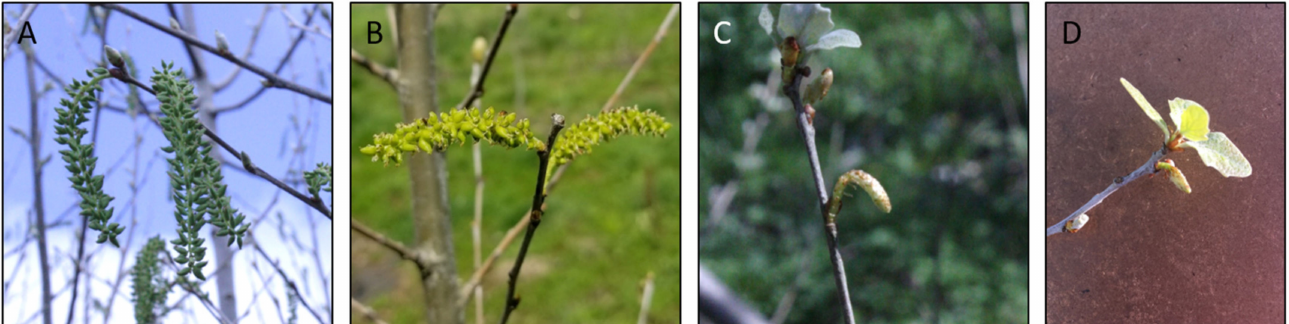
Figure 3. Catkin phenotypes were stable between the two field trials. ( A ) Catkins of control trees from the initial field trial in 2015 and ( B ) control trees from the new trial in 2019 were similar in appearance, as were ( C ) diminutive catkins of transgenic sterile trees from the initial trial in 2015 and ( D ) transgenic sterile catkins from the new trial in